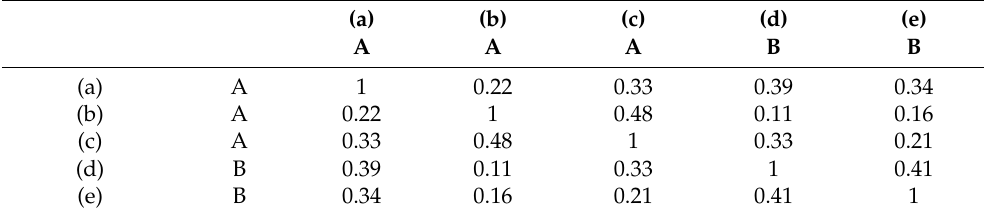
Figure 12. Mean values of RSRQ as a function of distance including the limits of the confidence interval for a confidence of 0.8. Table 9. Spatial correlation of RSRQ.